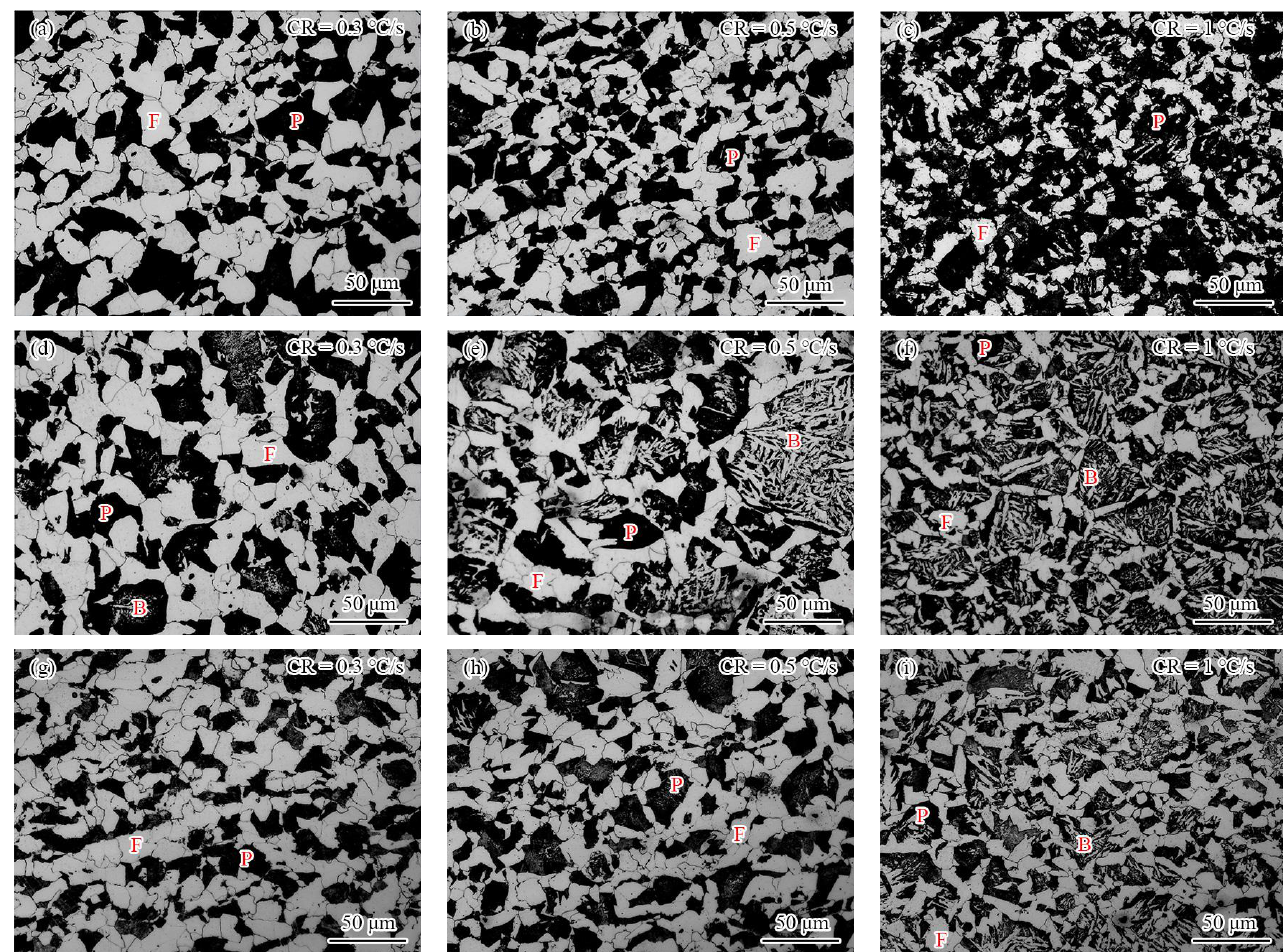
Figure 7. Microstructures of continuously-cooled specimens. ( a – c ) Nb-1, ( d – f ) Nb-2 and ( g – i ) Nb-3. “F”, “P” and “B” are denoted ferrite, pearlite and bainite, respectively. For Nb-1 steel with fine prior austenite grains, the shape of ferrite does not change significantly under the range of 0.3 to 1 °C/s. When the RT increases to 1200 °C, for Nb-2 steel, the formation of proeutectoid ferrite along the grain boundaries increases due to the coarsening of the prior austenite grains, as shown in Figure 7e-f. From the comparison of Nb-2 steel and Nb-3 steel, the presence of deformed austenite grains at lower CR reduces the amount of pre-eutectoid ferrite formed along the grain boundaries in Nb-3 steel. The changes in the average grain size and volume percentage of ferrite under the range of 0.3 to 1 °C/s are shown in Figure 8. The average grain size of ferrite in Nb-2 steel is larger than that of Nb-1 steel and Nb-3 steel, but the volume percentage of ferrite is the lowest. The average grain size and volume percentage of ferrite in Nb-1 steel and Nb-3 steel have little difference. Compared with Nb-2 steel, there are deformed austenite grains in Nb-3 steel, which can effectively refine the ferrite grain size, promote ferrite transformation, and in- crease the content of ferrite. Figure 8. ( a ) Average grain size and ( b ) percentage of ferrite.